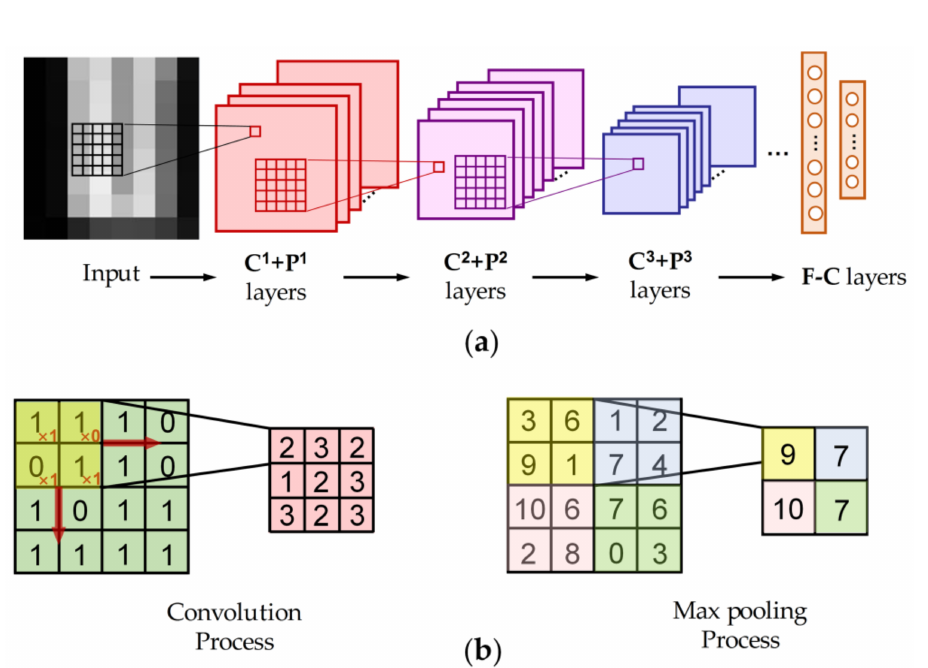
Figure 1. ( a ) The structure of a traditional convolutional neural network (CNN), ( b ) the process of convolution (kernel size: 2 × 2) and max pooling (pooling size: 2, stride: